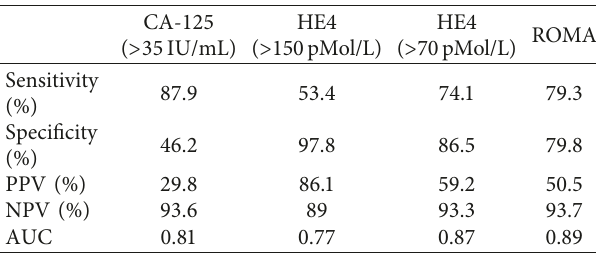
Table 3: Compare the sensitivity, specificity, PPV, and NPV of CA- 125, HE4, and HE4 at new cutoff point and